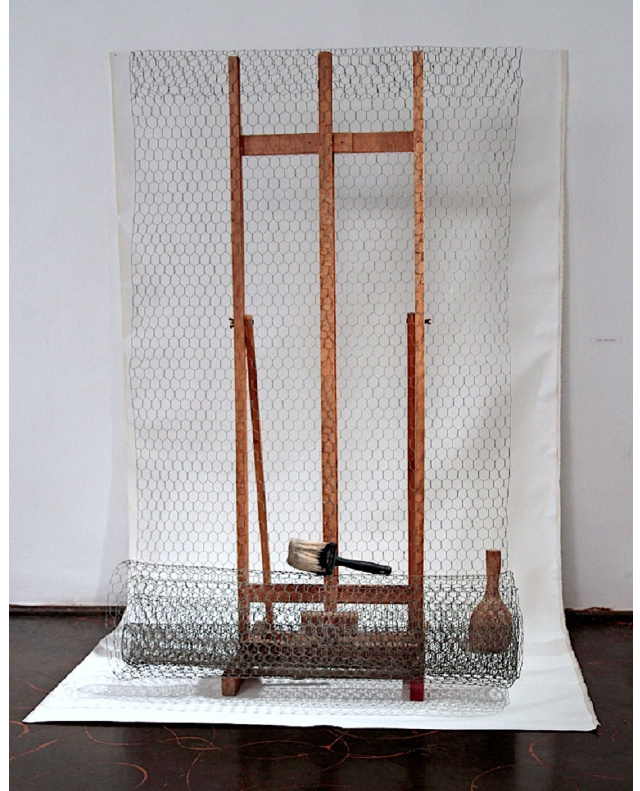
Figure 12. Leon Podsiadły, Sztaluga obiekt [ Easel Object ], 2012, ready made (easel, brush, chicken wire, jug). Photograph by Andrzej Rerak. Photograph shared courtesy of Entropia Gallery and with the permission of the artist’s family.